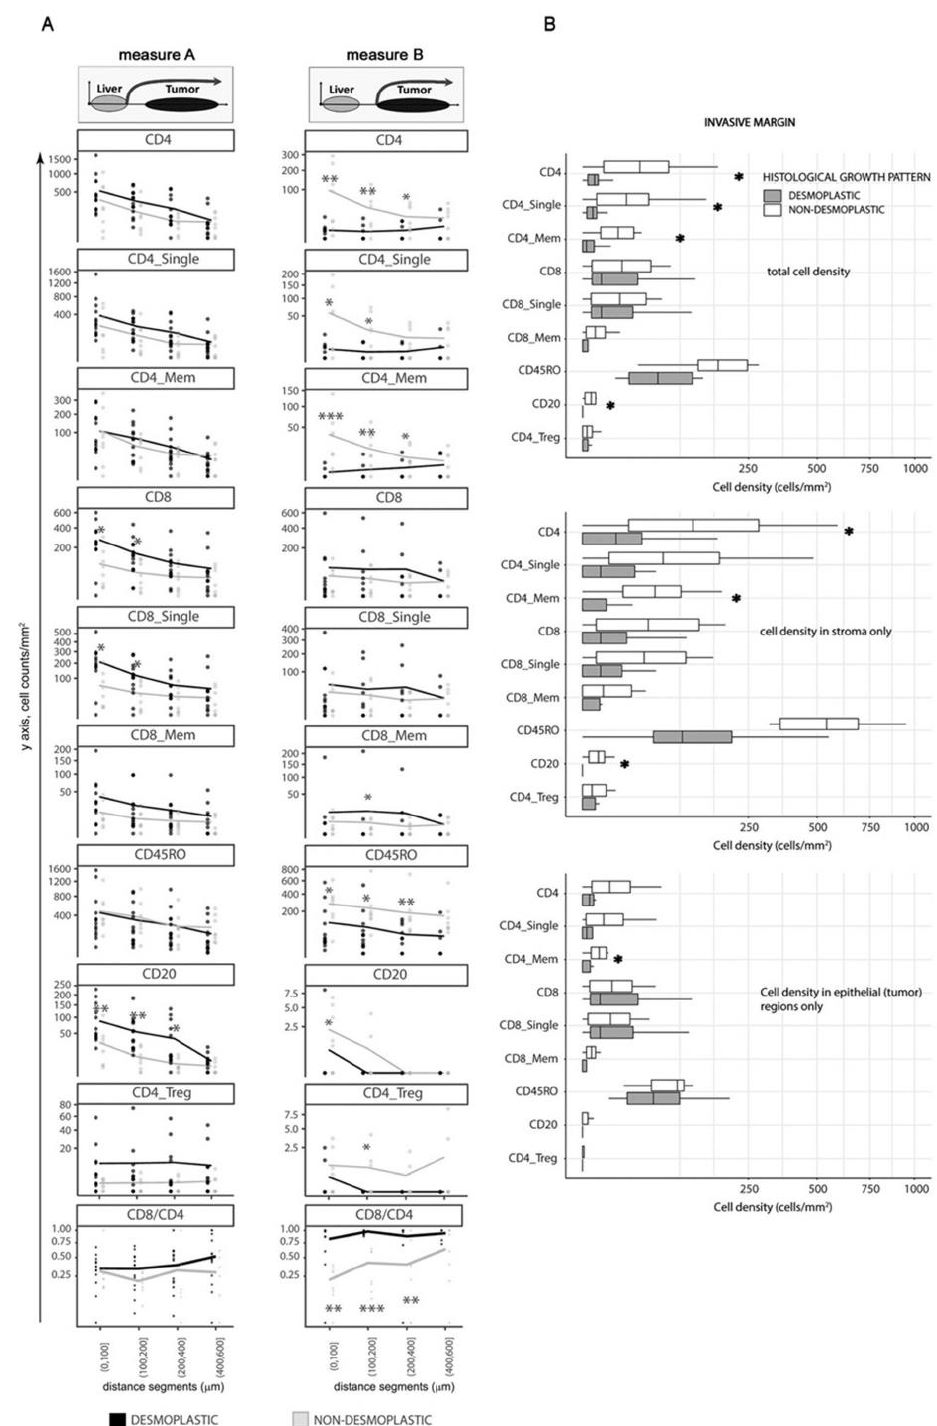
Figure 3. ( A ) Spatial assessment of lymphocyte subsets in d HGP and nd HGP CRC-LM according to two different measures, Measure A, from liver margin, Measure B, from the outer tumoral region (invasive margin). Lines show mean levels of cell densities. Dots show cell count/mm 2 . X -axis is square-root transformed (distant segments, µ m). Mann–Whitney U test was applied for statistical analysis. ( B ) Boxplots of cell densities (cells/mm 2 ) for each of the subsets were assessed and stratified by HGP according to the invasive margin. Asterisks illustrate p value < 0.05, Mann–Whitney U test comparing d HGP vs. nd HGP.